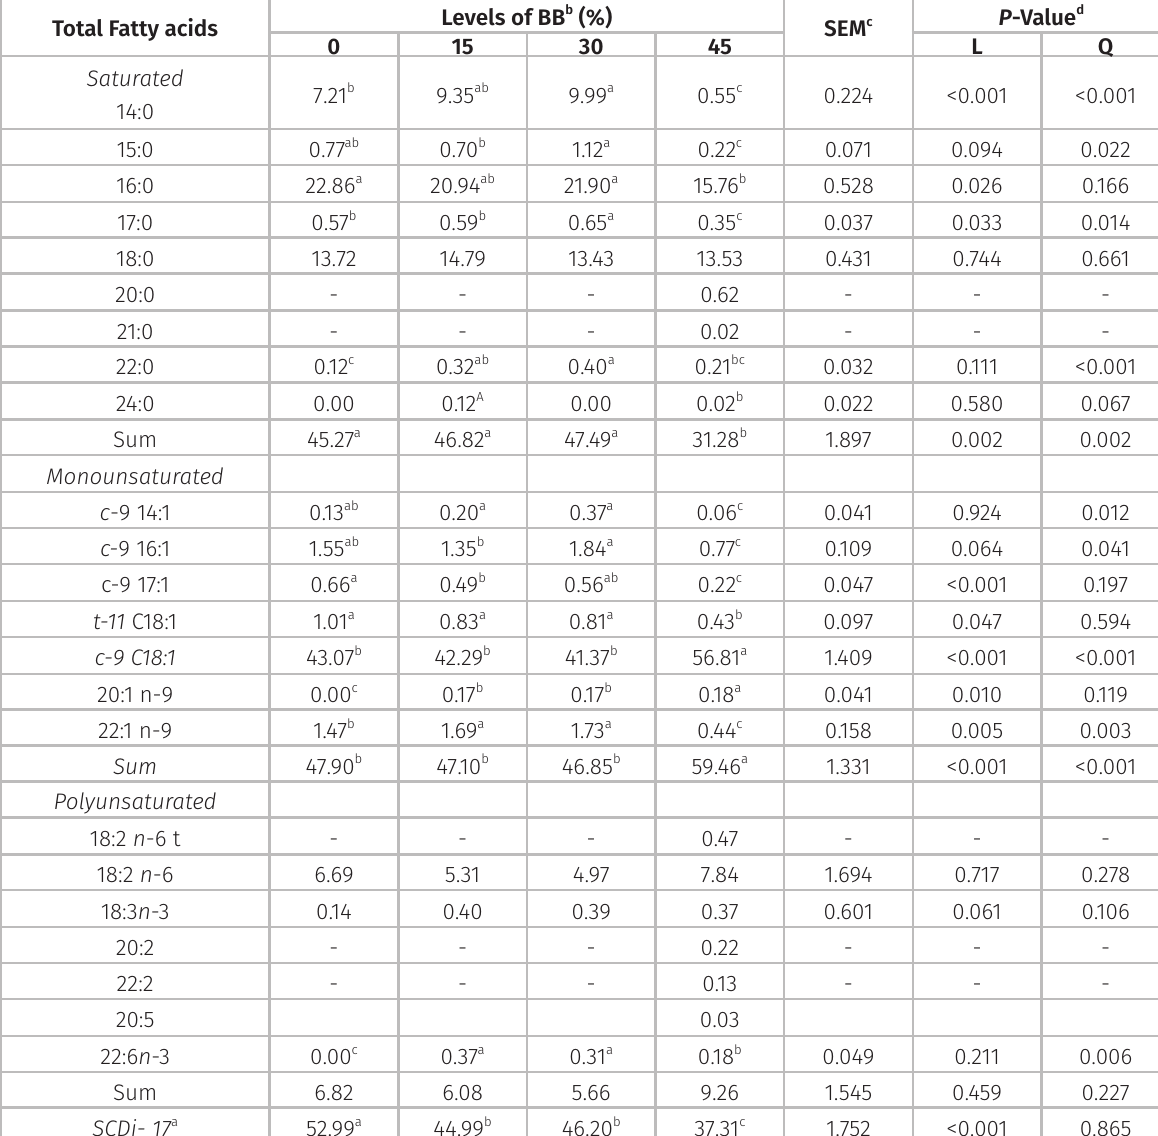
Table V. Fatty acid profile (g/100 g of muscle) of Longissimus thoracis et lumborum muscle of lambs fed with biscuit bran (BB). Total Fatty